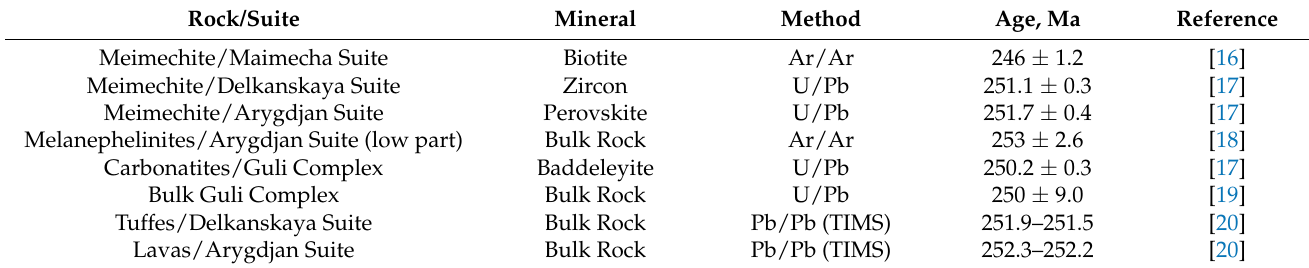
Table 2. Age of the igneous rocks of the Guli volcanic–plutonic complex [15].